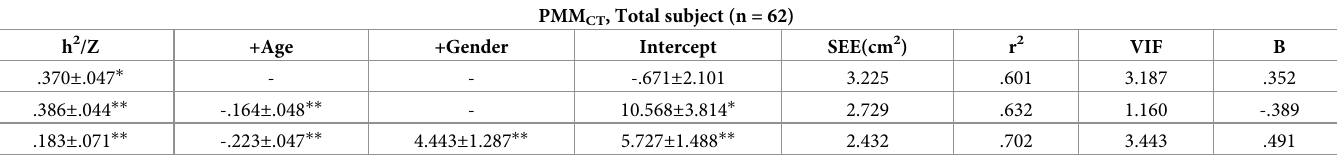
Table 2. Multiple regression analysis results for PMM CT , based on impedance index and